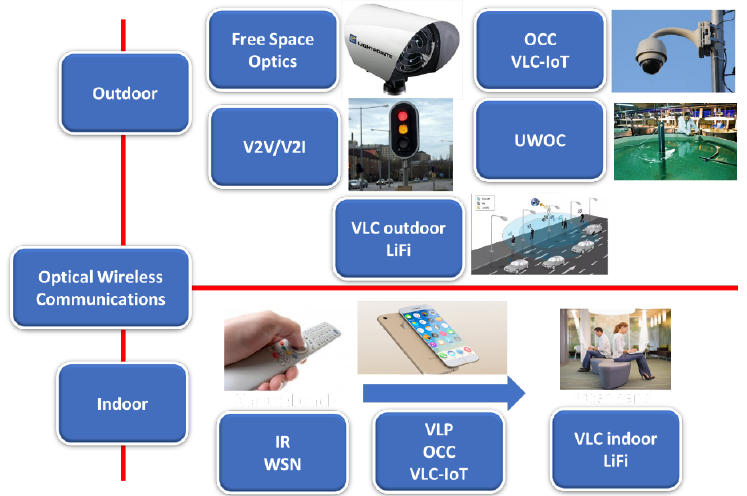
Figure 3. OWC technologies to be used in the tourism